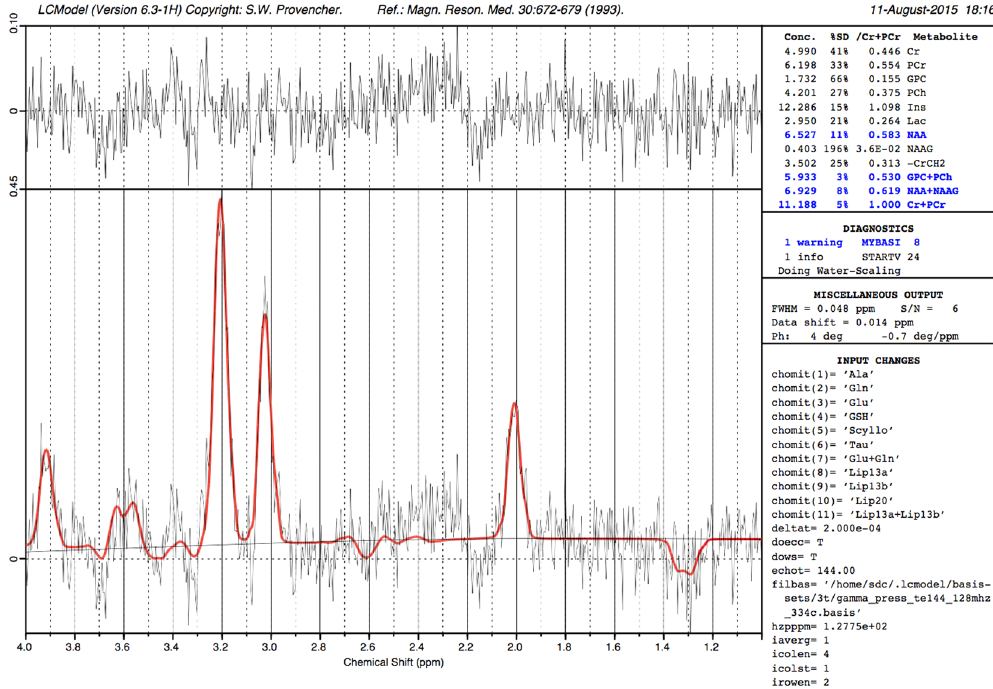
Figure 3. Typical good quality LCmodel spectra output obtained in a healthy control at 39.43 weeks of